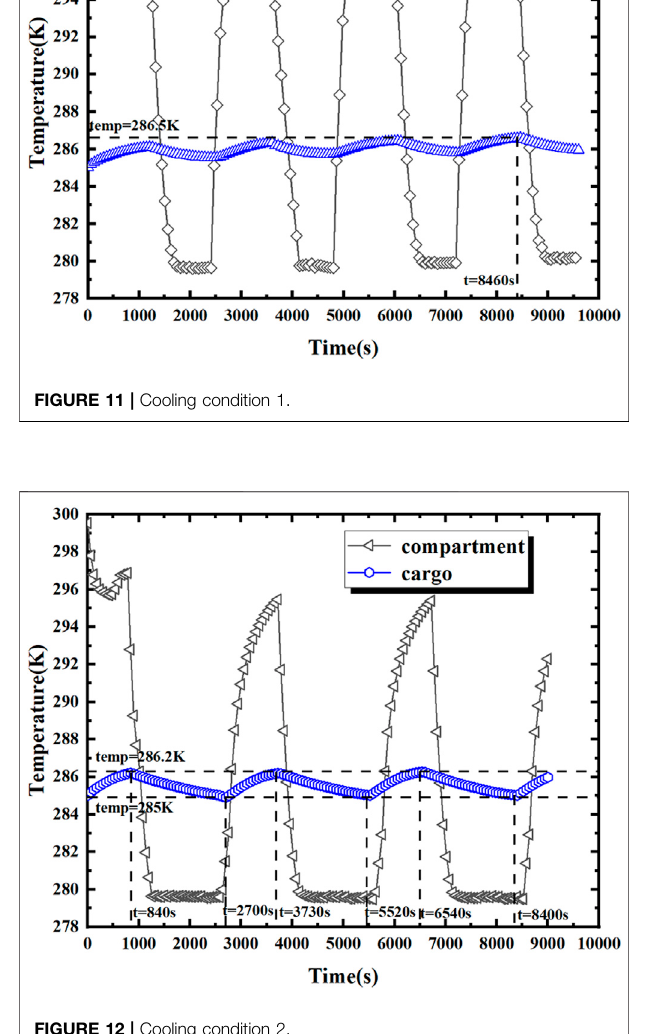
FIGURE 12 | Cooling condition 2.